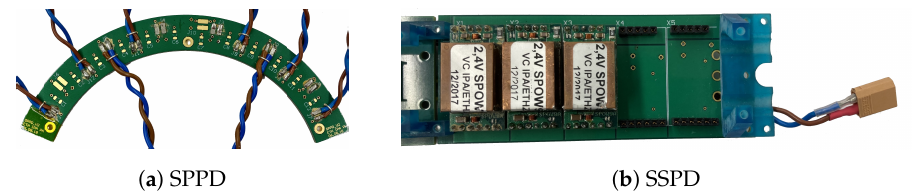
Figure 12. ( a ) The SPPD is responsible for distributing the main digital power. Two of these PCBs are part of SAFIR-I, each connecting the external power supply to 6 SSPD PCBs. ( b ) Each SSPD